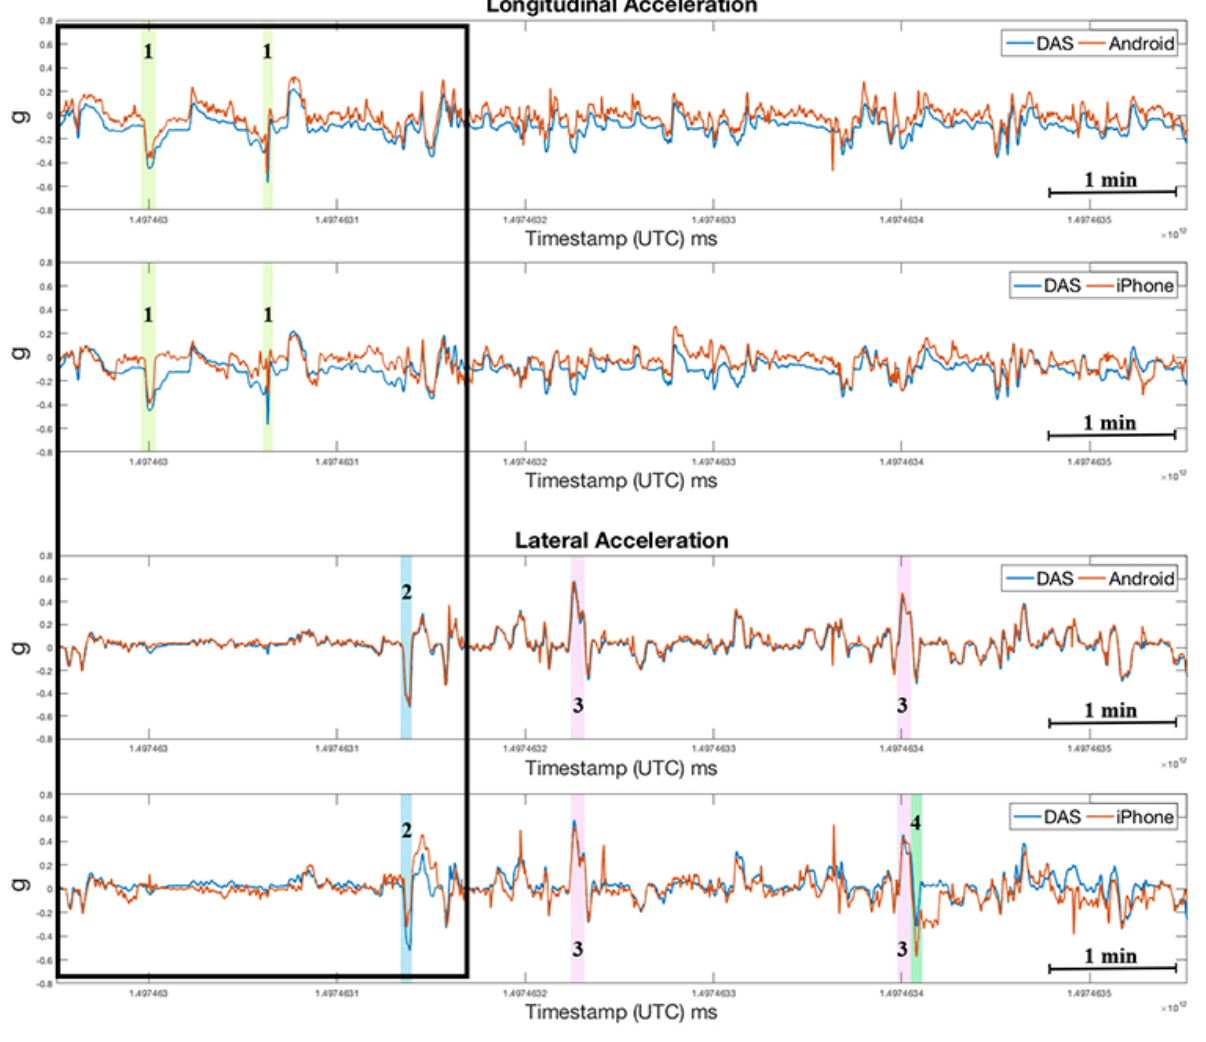
Figure 11. Acceleration measurements acquired during street driving in Christiansburg, VA. Highlighted are maneuvers that exceeded 0.45 g threshold: hard brake (1), hard right turn (2), hard left U-turn (3), and pothole (4). Details during first 3.4 minutes of driving within the black box are annotated in Figure 12. DAS: data acquisition system; UTC: Coordinated Universal Time.